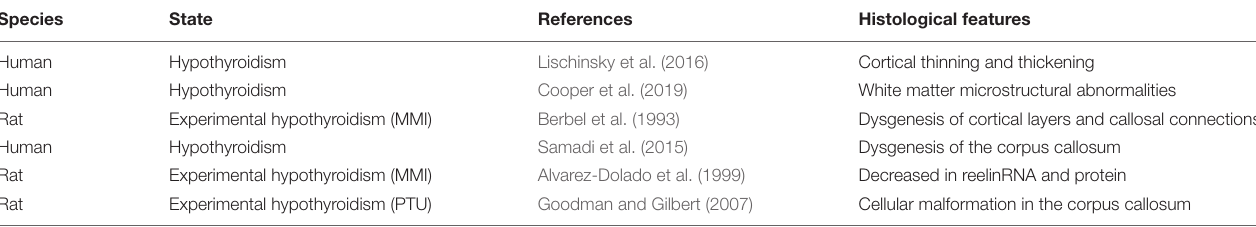
TABLE 1 | Role of thyroid hormone on the brain architecture.